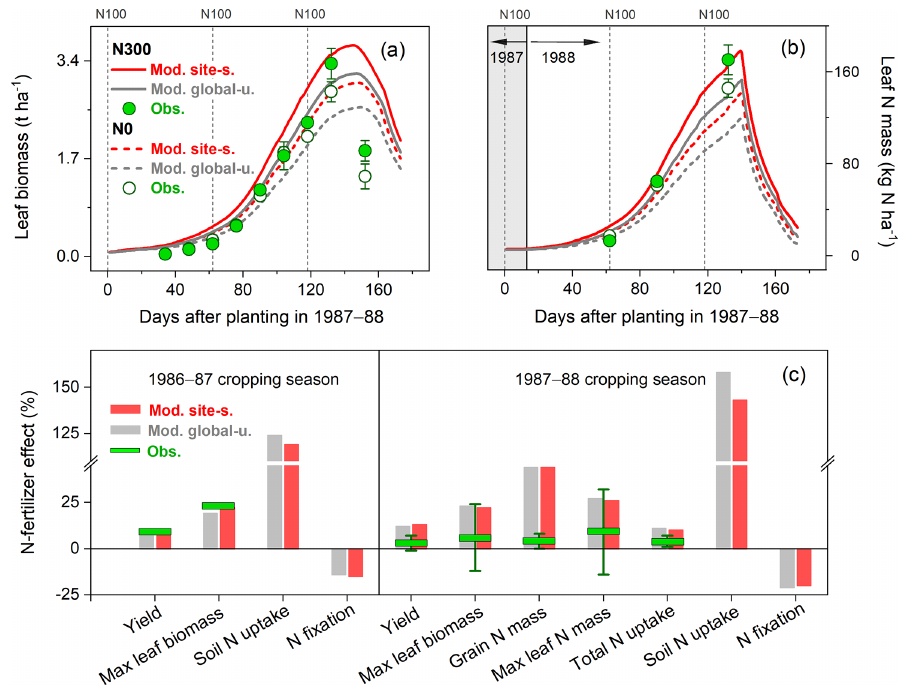
Figure 7. Observed and modeled seasonal pattern of leaf biomass (a) and leaf N (b) of faba bean in Spain for the cropping season 1987– 1988, with two different levels of N fertilizer input (0 and 300kgNha − 1 represented as N0 and N300, respectively), and the response of faba bean yields and N uptake to fertilized treatment at harvest (c) compared with those grown in unfertilized conditions in the 1986–1987 and 1987–1988 cropping seasons. The observed values were derived from the average of two faba bean varieties described in Mínguez et al. (1993), and their measured ranges are shown by the vertical bars. The vertical dashed lines in (a) – (b) represent the timing and amount of fertilizer applied in the N300 treatment.